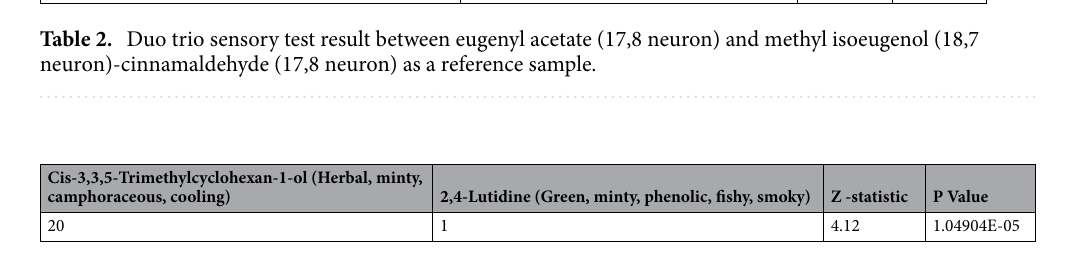
Figure 4. Molecules extracted from the two nearest neuron (26,8) and (27,7) of the SOM. (left side fig.) depicts the PCA for mass spectrum, (right side fig.) describes the 96-dimensional binary odor descriptors of these two neurons. Each no. indicates the odorant molecule reported in supplementary file 2 (Table S2). Eugenyl acetate (Fruity, sweet, spicy, balsamic, warm)